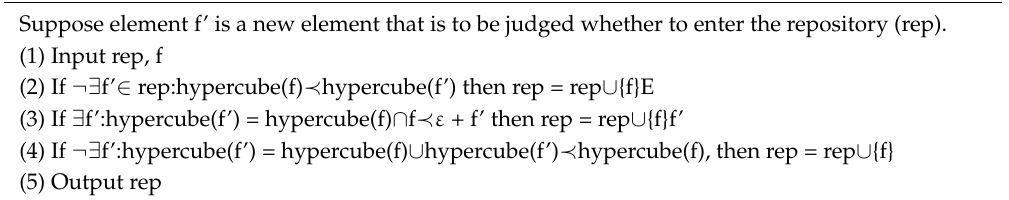
Algorithm 3. The Update Function of the Dominance Archive